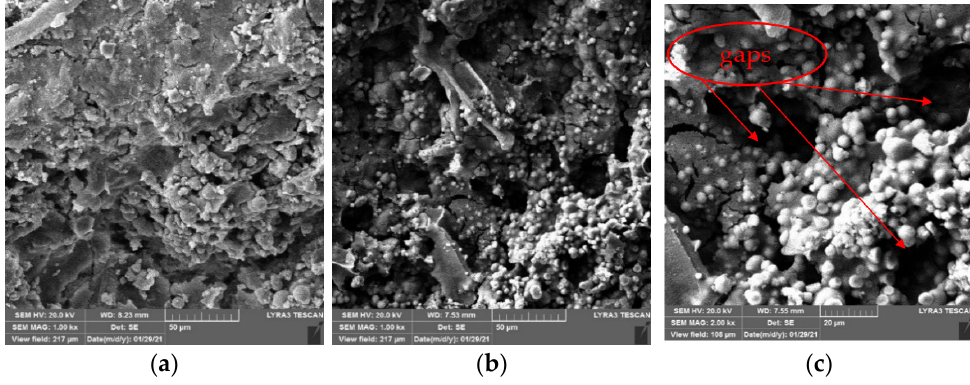
Figure 13. SEM images of specimens repaired by negative pressure method. ( a ) 1 kx. ( b ) 1 kx. ( c ) 2 kx.